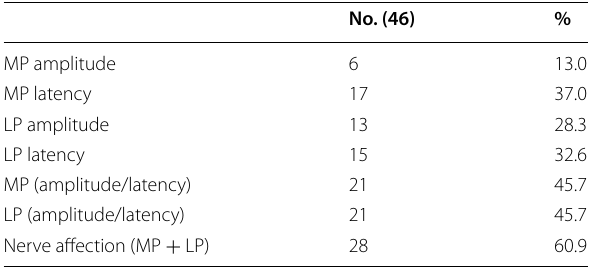
Table 1 Number of positive cases and percentage of positive routine NCSs among all cases